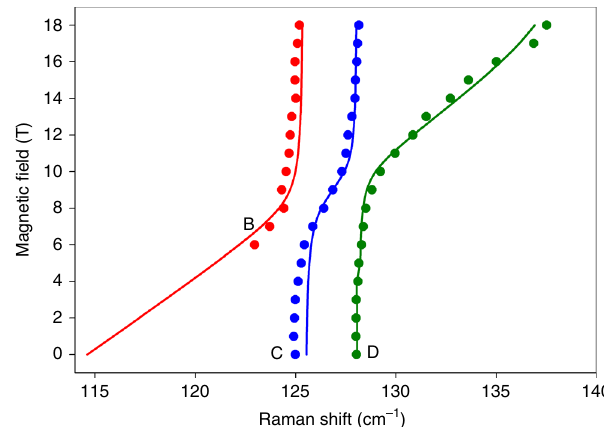
Fig. 5 Fitting of the Raman spectra. Simulated (solid lines) and experimental (circles) positions of fi eld-dependent ( B || z ) Raman transitions corresponding to peaks B (red), C (blue) and D (green) of 1 . g z = 1.49, ħ ω 1 = 125.4 cm − 1 , ħ ω = 128.1 cm − 1 , ħ ω = 139.5 cm − 1 (not shown in the 2 3 = 1.14 cm − 1 , E = 0.88 cm − 1 , E = 2.66 cm − 1 [ E / D = 0.17 (ORCA fi gure); E 1 2 3 NEVPT2); 2 D' = 115 cm − 1 ]. E 1 , E 2 and E 3 from the vibronic calculations are the coupling constants | Λ 1 |, | Λ 2 | and | Λ 3 |, Eq. (2), respectively, for the interaction with the ħ ω 1 , ħ ω 2 and ħ ω 3 modes. Simulated and experimental positions of fi eld-dependent ( B || x and B || y ) Raman transitions are given in Supplementary Fig. around 114 cm − 1 at B = 0, traces 1 and 2 are the ϕ 1 |0 〉 → ϕ 4 |0 〉 (red line I) and ϕ 1 |0 〉 → ϕ 3 |0 〉 (red line II) transitions,